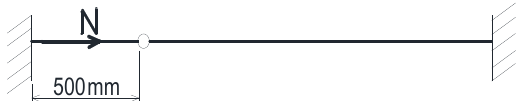
Figure 1. The static schematics of the model.